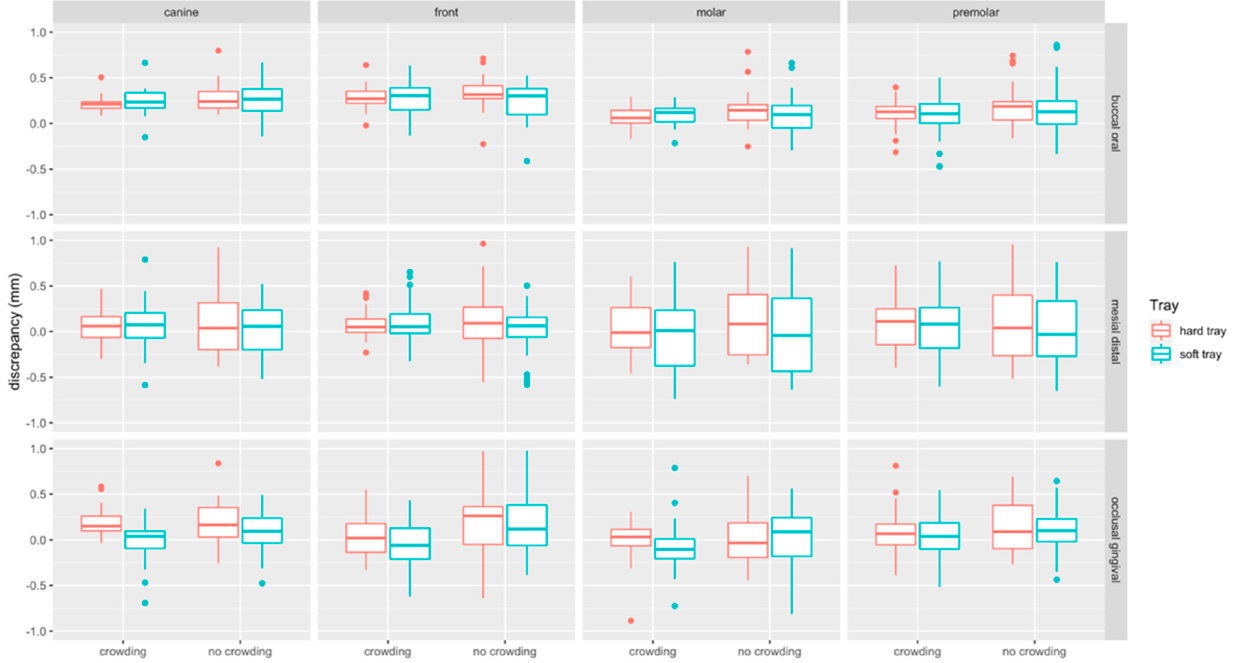
Figure 7. Boxplots detailing the accuracy of bracket transfer for lingual measurements. Results are summarized for the canines, front teeth, molars, and premolars and split up into hard/soft trays and no crowding/crowding. A positive/negative value indicates mesial/distal, buccal/oral or occlusal/gingival displacement, respectively.